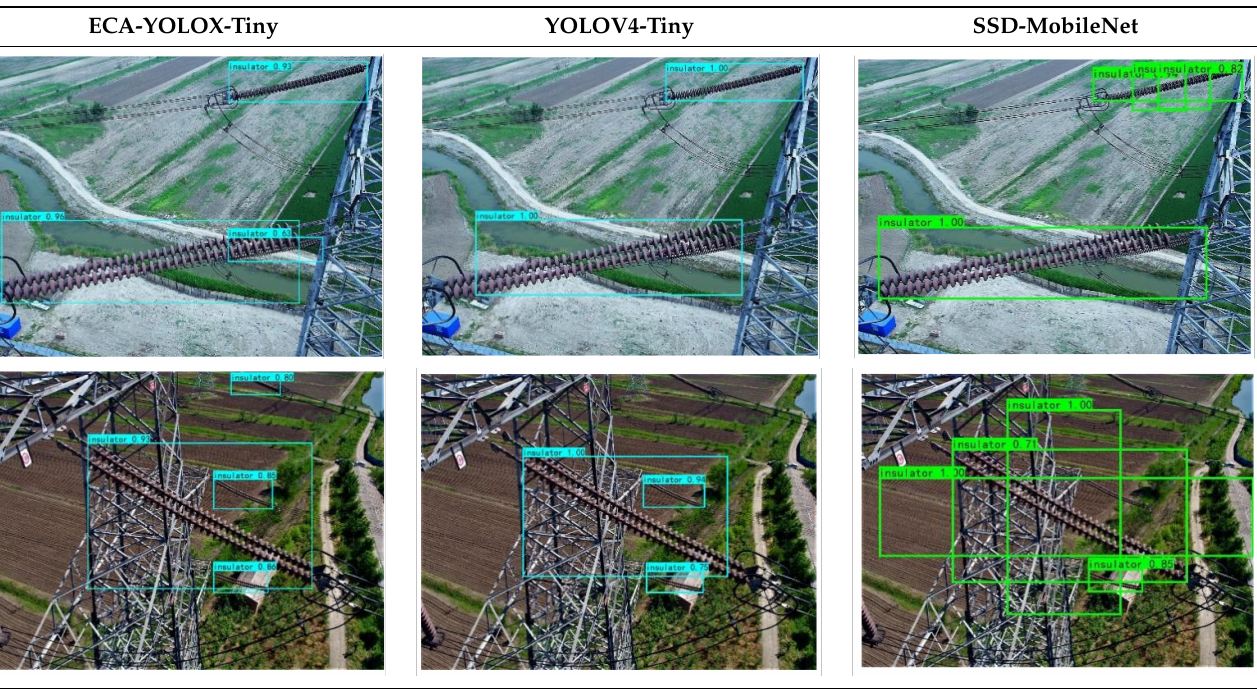
Table 9. The detection effect of three models for multi-target normal insulators with different complex